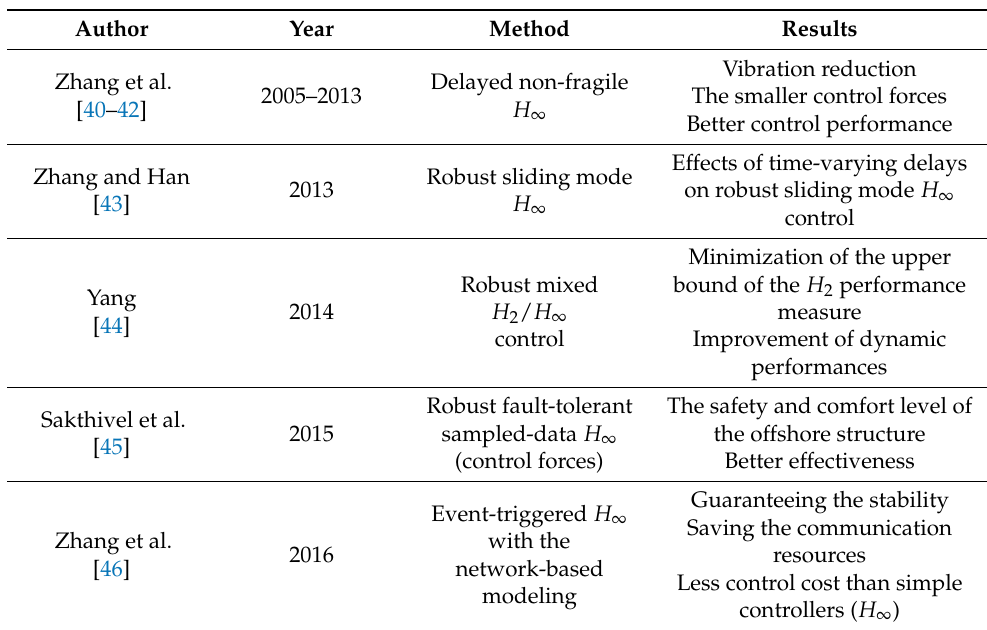
Table 2. Various H ∞